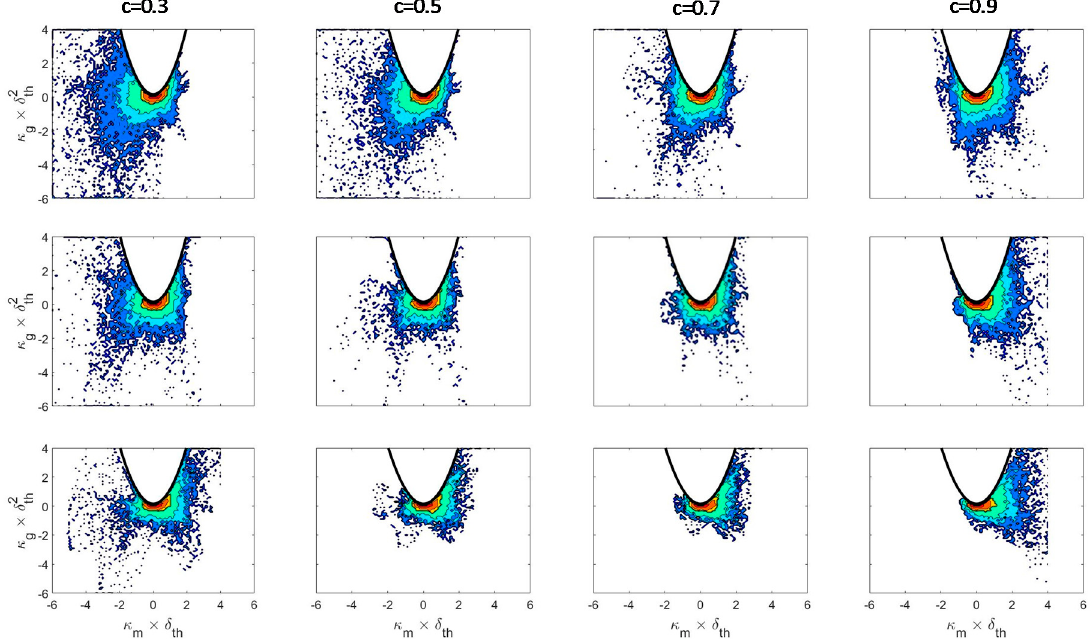
Figure 3. Joint PDF (coloured from blue to dark red) between normalised curvature κ m × δ th and normalised Gauss curvature κ g × δ 2 for c = 0.3, 0.5, 0.7 and 0.9 (1st–4th column) isosurfaces for cases Le = 0.8,1.0 and 1.2 (1st–3rd row).